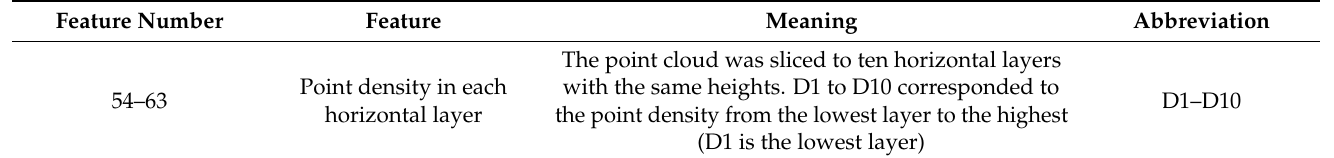
Table 7. Point cloud density